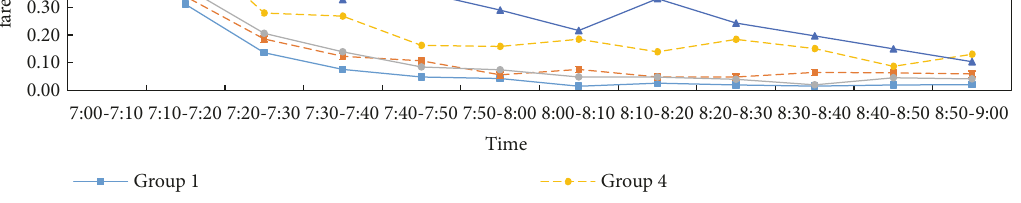
Figure 10: Distribution of retiming elasticities of different passenger groups in the middle